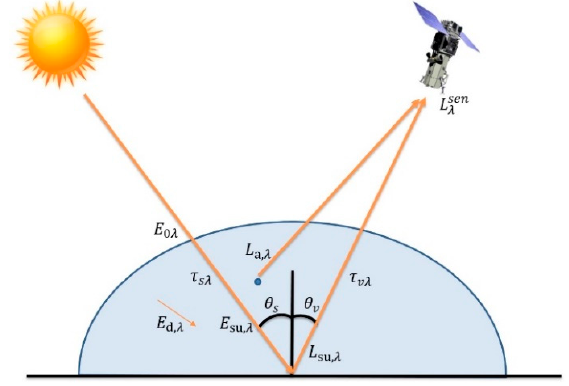
Figure 3. Model of atmospheric influence.